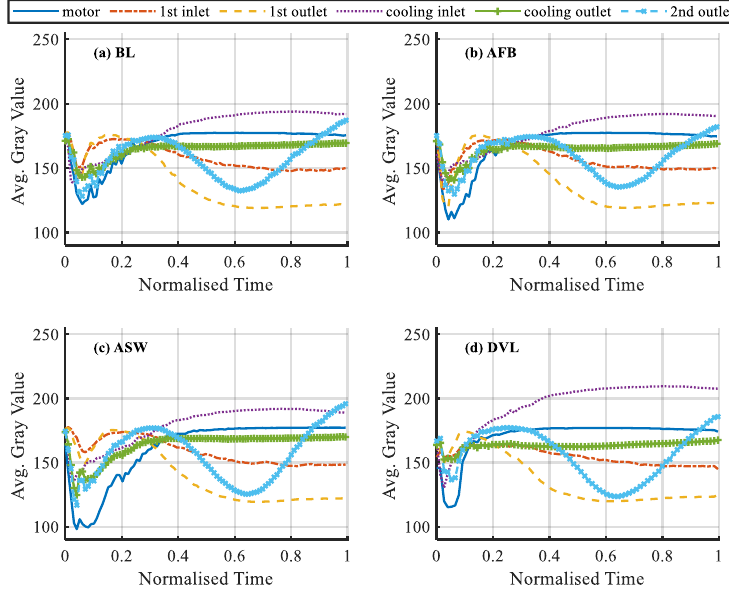
Figure 6. The average grayscale value of the six regions under di ff erent working conditions in which the variation process is normalized by operating time ( a – d ).